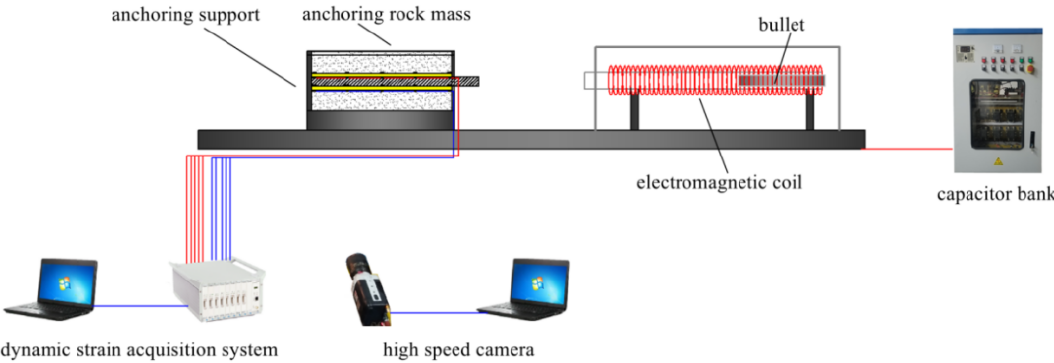
Figure 1. Impact test diagram of transparent rocklike—anchoring structure.